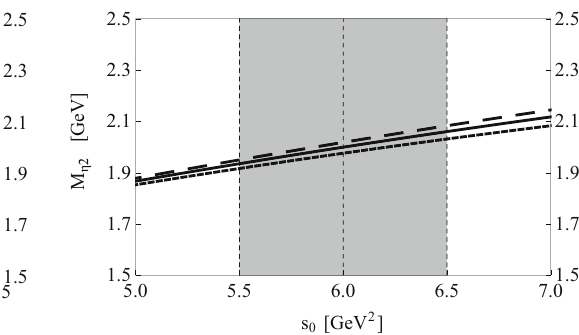
, as obtained by setting s 0 = 5 . 5 / 6 . 0 / 6 . 5 GeV 2 , respectively. In the right 2 panel,theshort-dashed/solid/long-dashedcurvesareobtainedbysetting = 1 . 6 / 1 . 8 / 2 . 0 GeV 2 , M 2 B